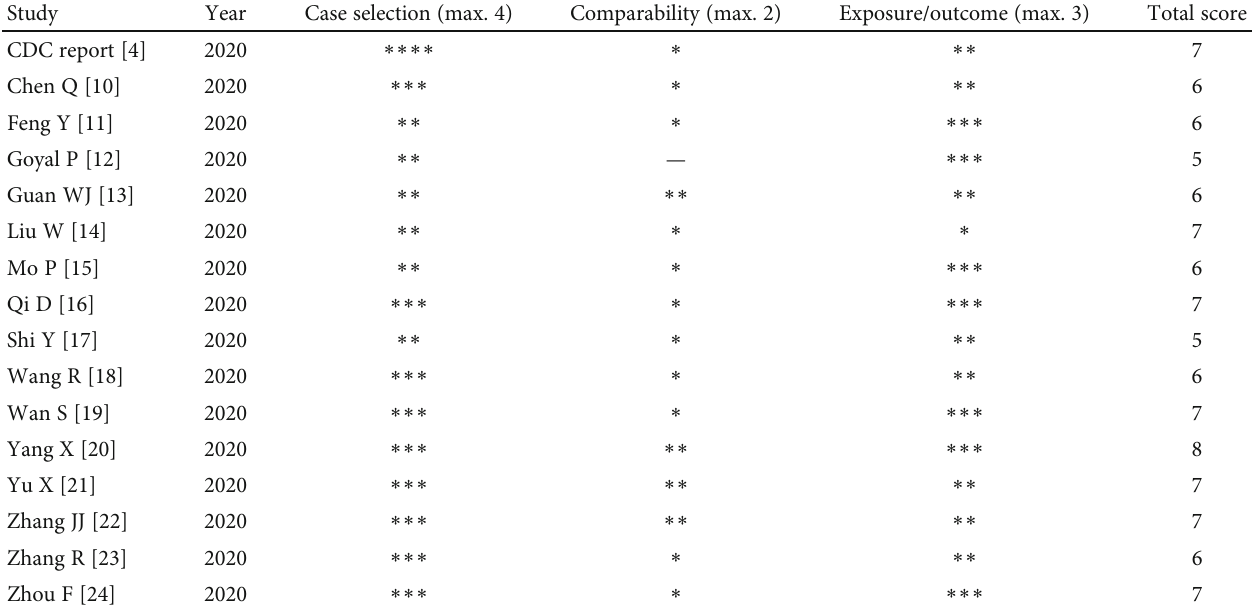
Table 1: Newcastle-Ottawa scale for quality assessment and risk of bias.